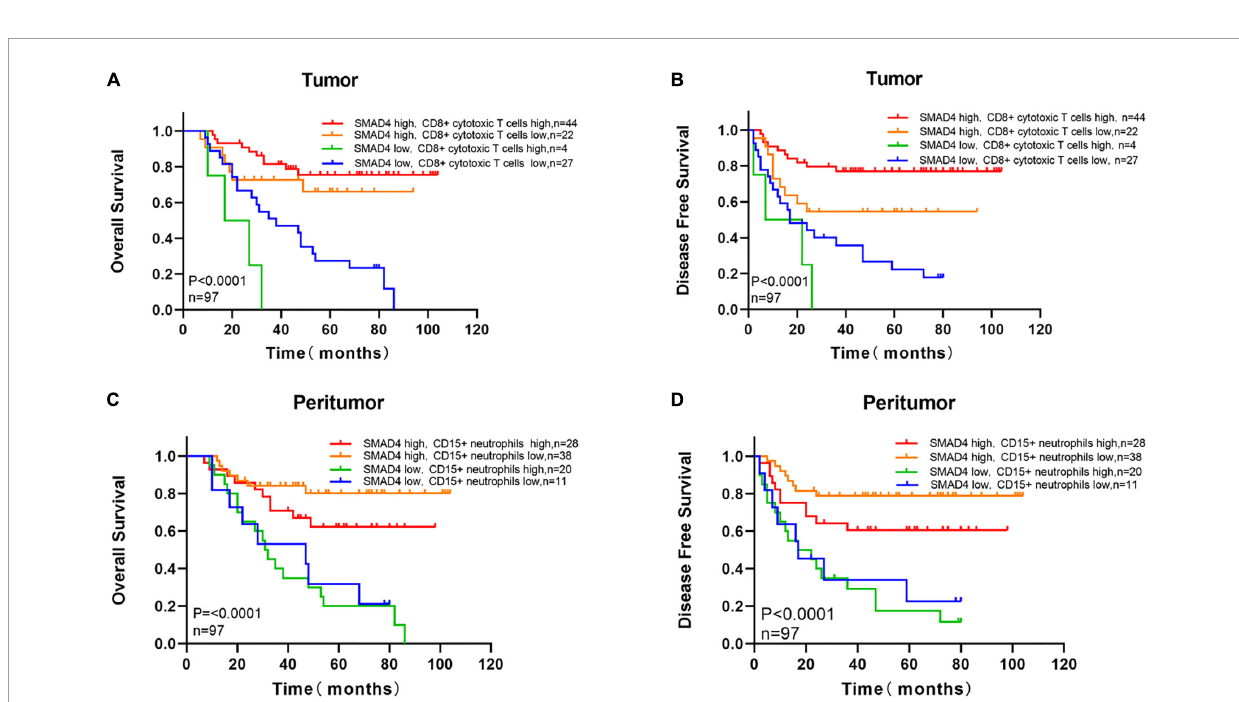
FIGURE6 Survival analysis with respect to SMAD4 expression combined with infiltration of intratumoral CD8 + cytotoxic T cells and density of peritumoral CD15 + neutrophils. Overall survival (A) and disease-free survival (B) with respect to high/low SMAD4 expression levels with high/low infiltration levels of CD8 + cytotoxic T cells tumor infiltration. Overall survival (C) and disease-free survival (D) with respect to high/low SMAD4 expression levels with high/low density of CD15 + neutrophils in peritumor